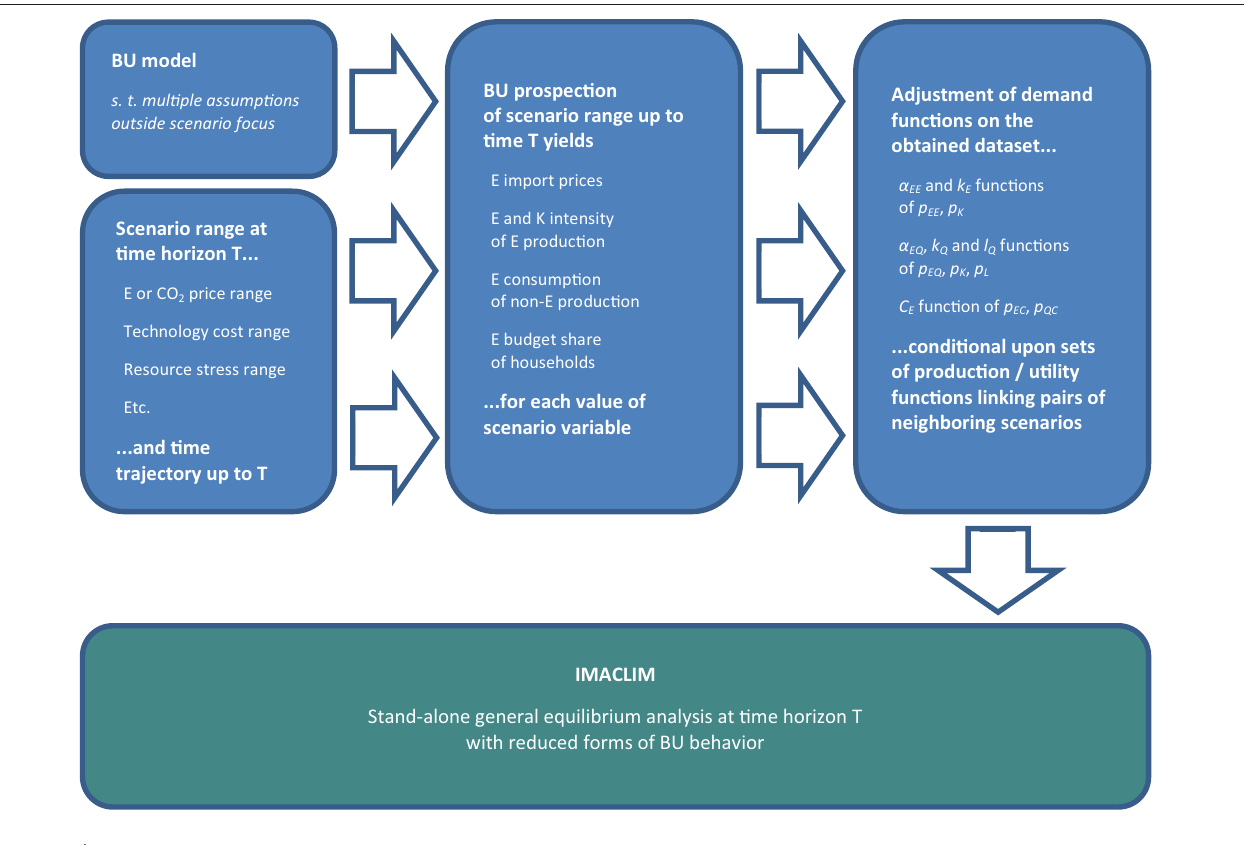
FIGURE 2 | Calibration of reduced forms of bottom-up behaviors.